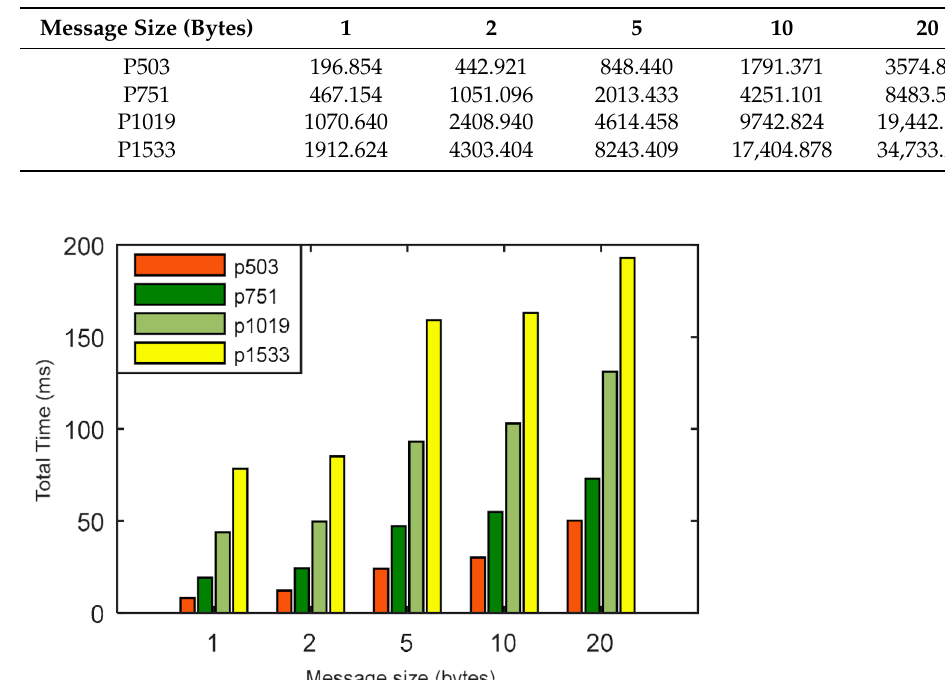
Figure 6. Comparison for energy (in millijoules) with message sizes (in bytes) for various p sizes. Table 5. Message size vs. energy consumption (mJ) for different p values.